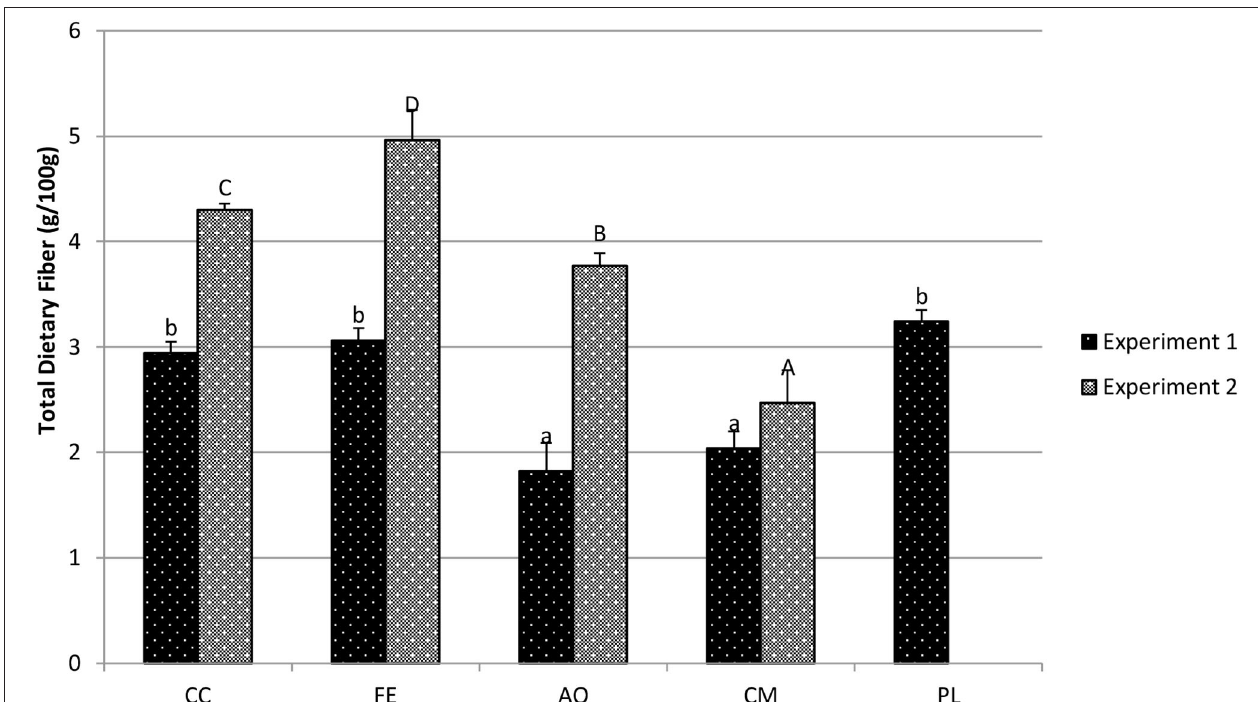
FIGURE 8 | Total dietary fiber in red giant mustard (g/100g fresh weight) determined with AOAC 991.43. Data shown are mean ± standard deviation for two different replicate experiments. Significant differences among mean values are indicated with different letters above bars ( p < 0.05) with lower-case letters for experiment 1 and capital letters for experiment 2. Results analyzed using ANOVA Tukey HSD for significance testing.